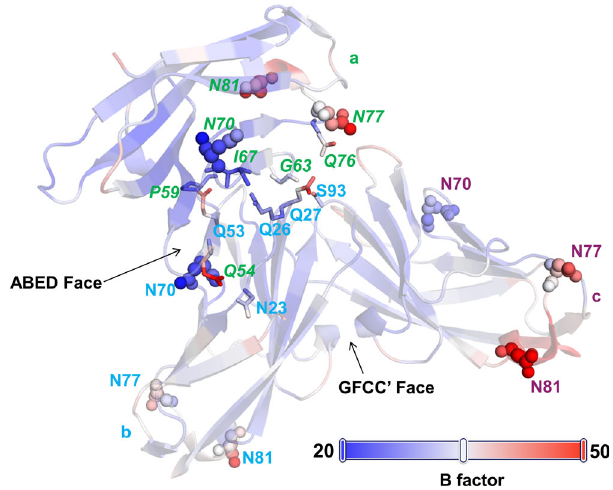
Fig. 5 Crystallographic Debye-Waller factor (temperature factor or B factor) assignment of the crystal structure of the hCEACAM1 IgV domain with GFCC ’ and ABED face interactions. The ribbon diagram of the hCEACAM1 molecules (a, b, and c), glycosylation sites (N70, N77 and N81 residues shown by spheres), and interacting residues at ABED face (shown by sticks) with B-factor assignment. The loops, α helices, β strand interacting ABED face residues and glycosylation sites are colored based on B-factor range (blue-white-red, where blue minimum = 20, red maximum = 50). B-factor assignments revealed higher thermal motion or dynamic mobility in the side-chains (red) in some of the residues including Q27, Q53, Q54 at the ABED face and glycosylation site residues (N70, N77, and